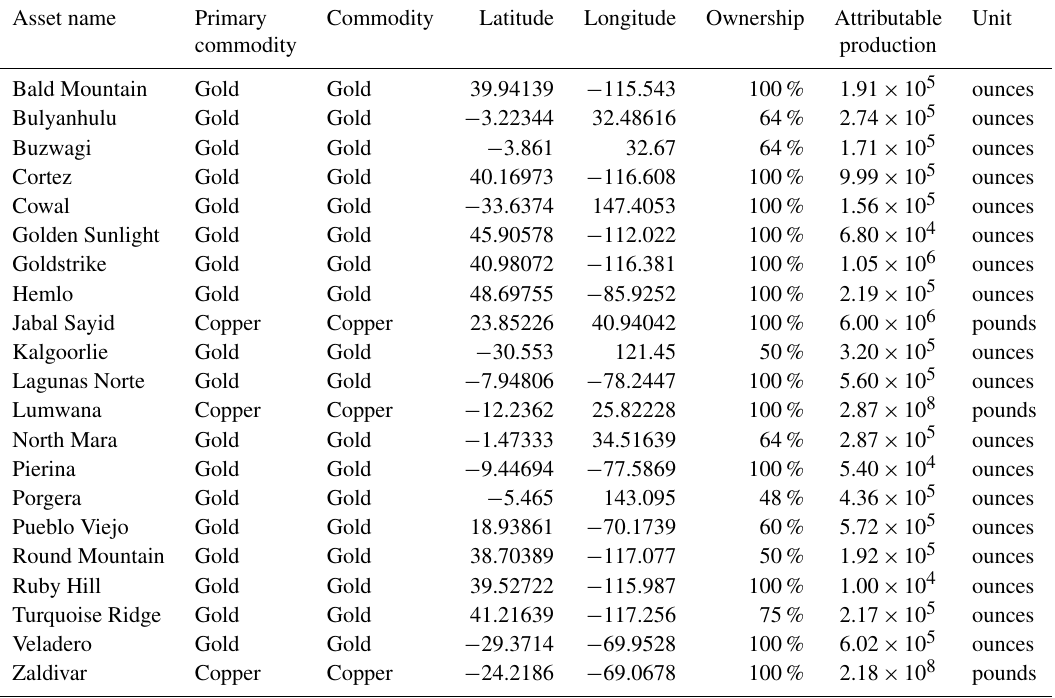
Table A2. Mining asset coordinates and attributable revenue per mine for Barrick gold for 2015.